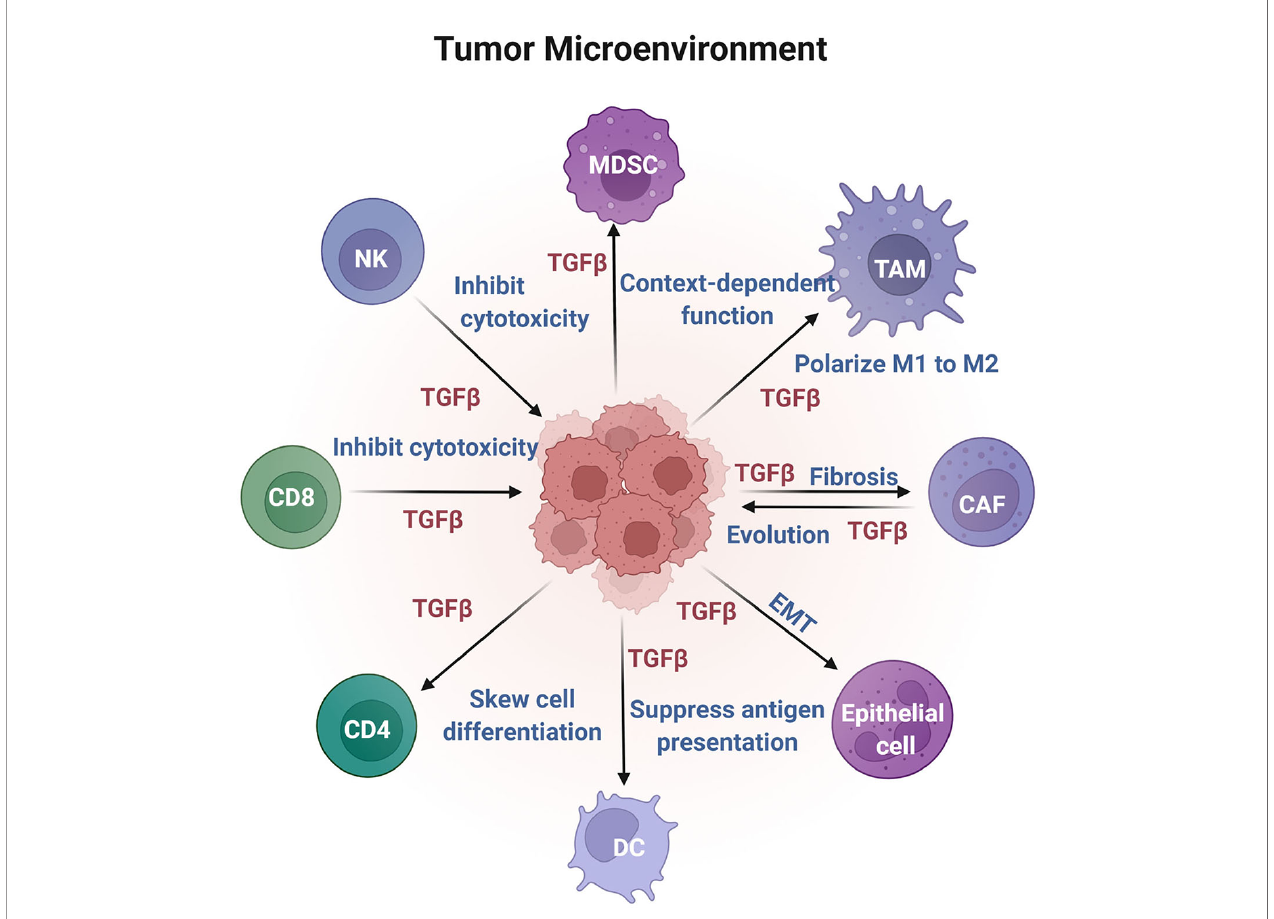
FIGURE 3 | Effects of TGF- b on different cell components in the TME. TGF- b is enriched in the TME and acts on nonimmune and immune cells to ful fi ll antitumor or protumor growth